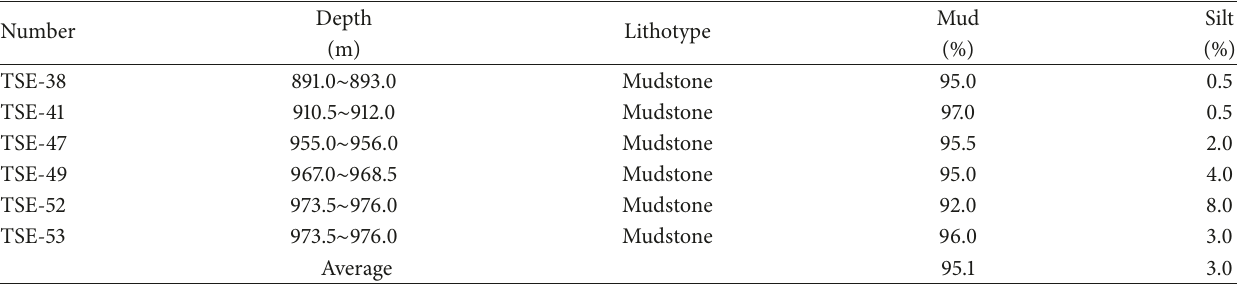
Table 4: TSE results of interlayers in Well